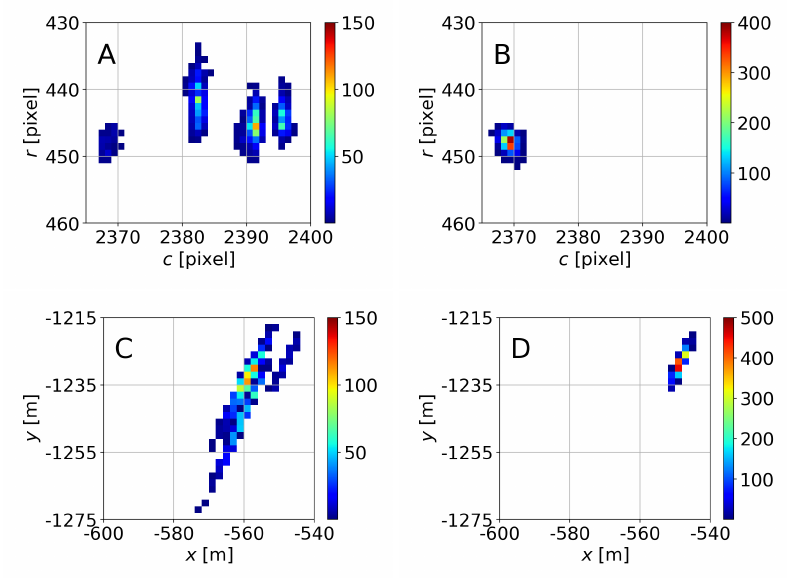
Figure 12. 2D-histograms of the pixel coordinates tracking a feature before ( A ) and after ( B ) stabiliza- tion and similar results expressed in the xy coordinates ( C and D , respectively). The colorbar stands for the